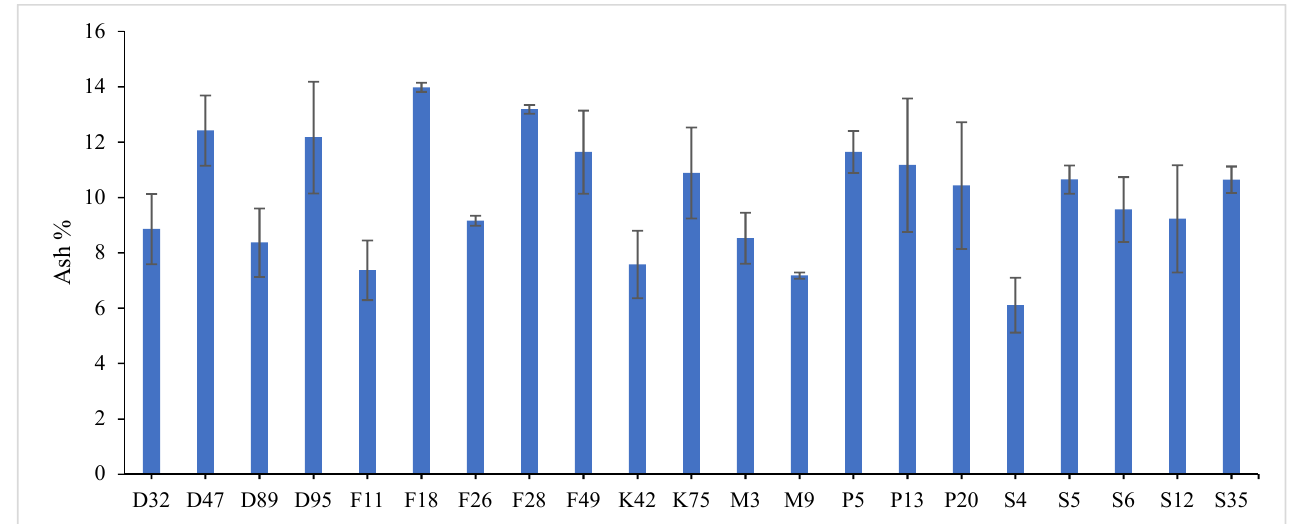
Figure 7. Mean performance of crude fiber % of twenty-one alfalfa genotypes in the first year. Bar represents the standard deviation.